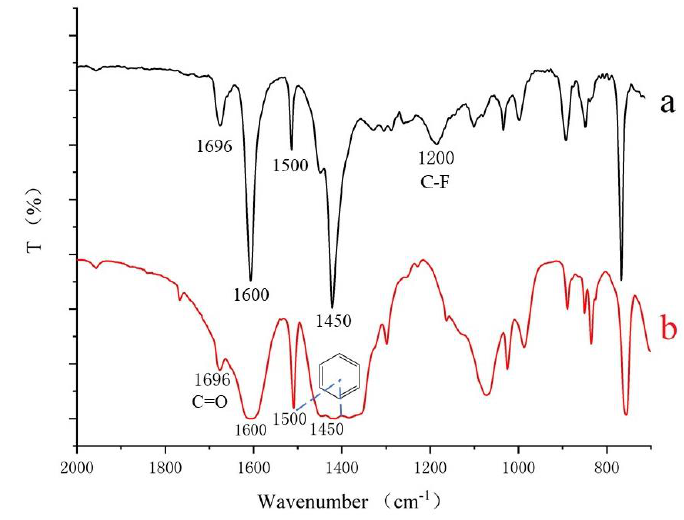
Figure 5. FTIR spectra of MIL-53 MMM ( a ), MIL-53 crystal ( b ).